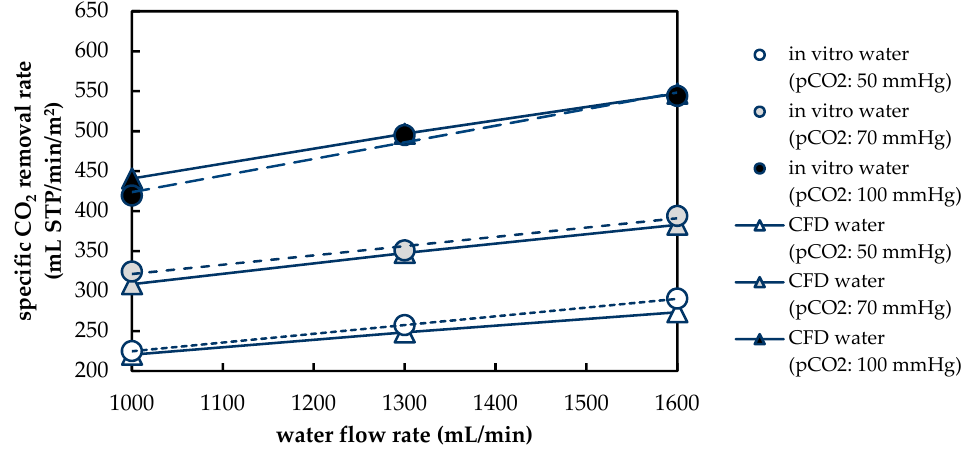
Figure 11. Comparison of CO 2 removal determined with experiments and CFD simulations for water.